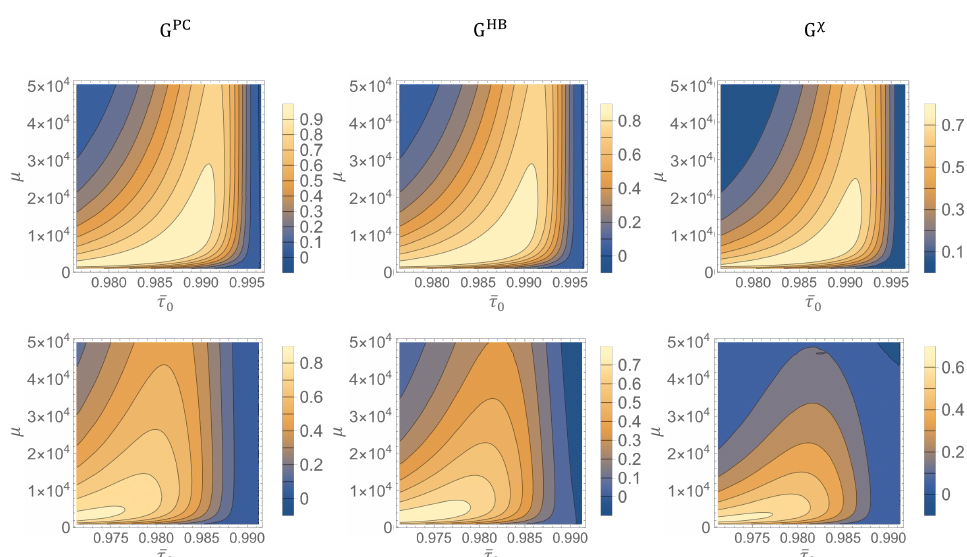
Figure 3. Quantum Gain. We show the quantum gain G as a function of the mean number of signal photons µ and the mean value of the transmittance ¯ τ 0 of one encoding distributions. In the upper row, the other parameters are fixed to σ 0 = σ 1 = 0.001 and ¯ τ 1 = 0.997. Starting from the left: G PC is the quantum gain over to the performance of classical states an photon counting receiver, G HB over the optimal bound of classical states considering local readout, and G χ over the bound on the classical performance with global measurements. On the lower row we report the same figures of merit changing the parameters to σ 0 = σ 1 = 0.0025 and ¯ τ 1 = 0.991.